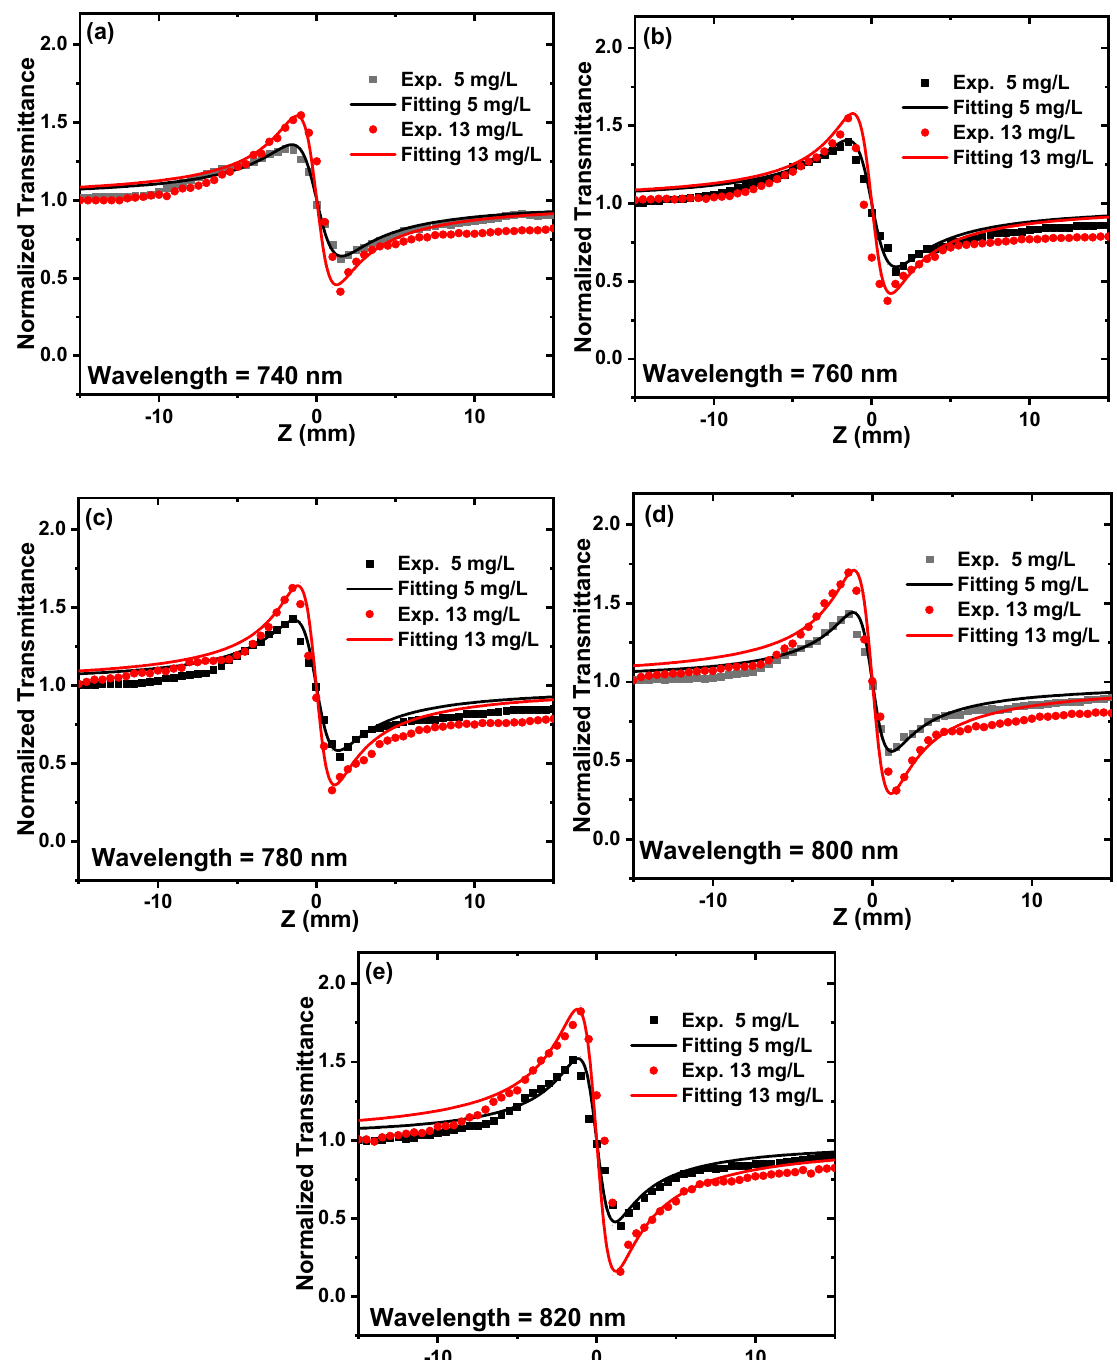
Figure 11. The nonlinear refractive index of ZnONPs colloids as a function of the incident peak intensity at a constant excitation wavelength of 800 nm. The CA Z-scan was performed at constant peak intensity of 15.8 GW/cm 2 and at dif- ferent excitation wavelengths of 740 nm, 760, 780, 800 nm, and 820 nm to study the de- pendance of the nonlinear refractive index on the excitation wavelength for the ZnONPs colloids, as shown in Figure 12a–e.